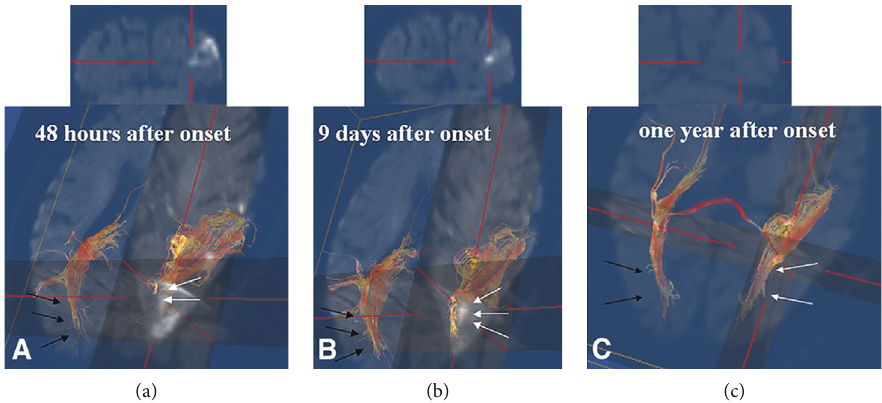
Figure 3: Di ff usion tensor imaging (DTI) performed two days after onset (a), nine days after onset (b), and one year after onset (c). (a) The optic radiation reaches the occipital pole in the right hemisphere (black arrow) but is completely interrupted in the left hemisphere, corresponding to a high-intensity area that appears like a white cloud caused by the local edema (white arrow). (b) The left optic radiation is interrupted to a lesser extent at the left cortical lesion (white arrow). (c) There is no longer an interruption visible in the left optic radiation (the optic radiation was reconstructed by using a deterministic algorithm: VOLUME-ONE V1.56 software program (reprinted with permission from Yoshida et al., J Neuroophthalmol 2006; 26: